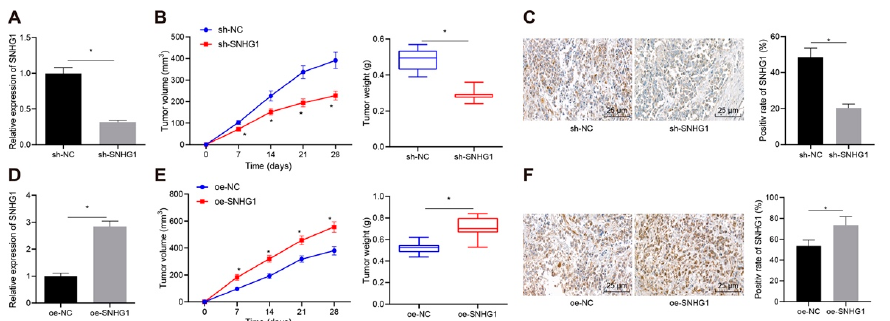
Figure 3. Overexpression of SNHG1 stimulates bladder cancer cell proliferation and represses cell apoptosis. ( A ) qRT-PCR determination of the overexpression efficiency of oe-SNHG1 in 5637 cells. ( B ) CCK-8 assay of the change of 5637 cell viability. ( C ) The changes of 5637 cell proliferation detected by EdU assay. ( D ) Flow cytometry analysis of the changes of 5637 cell apoptosis. ( E ) Western blot was repeated three times. Data were presented as mean ± standard deviation and compared by t